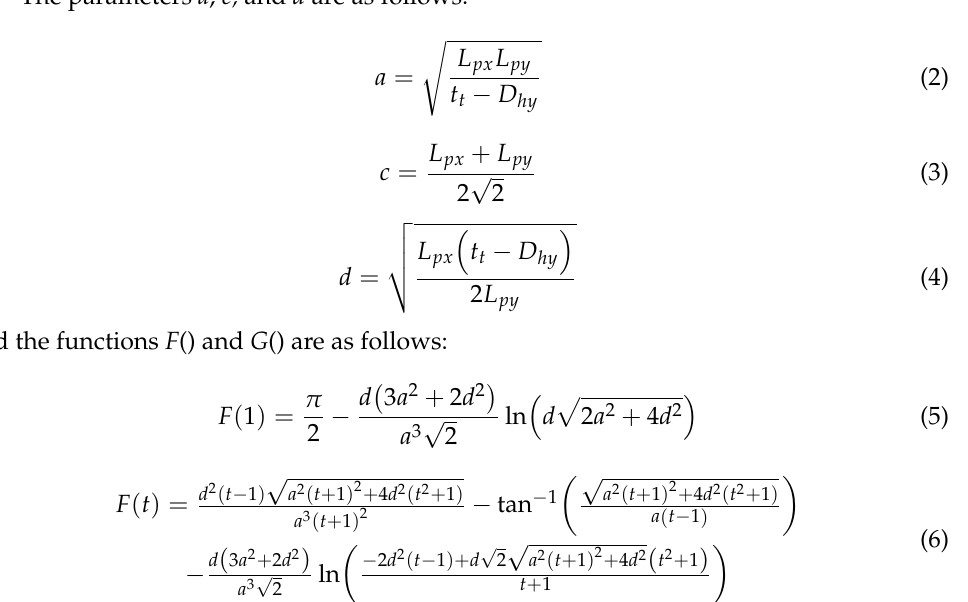
Figure 4. Three-dimensional representation of a hole and 3D surface area; definition of the parameters a , c, and d .